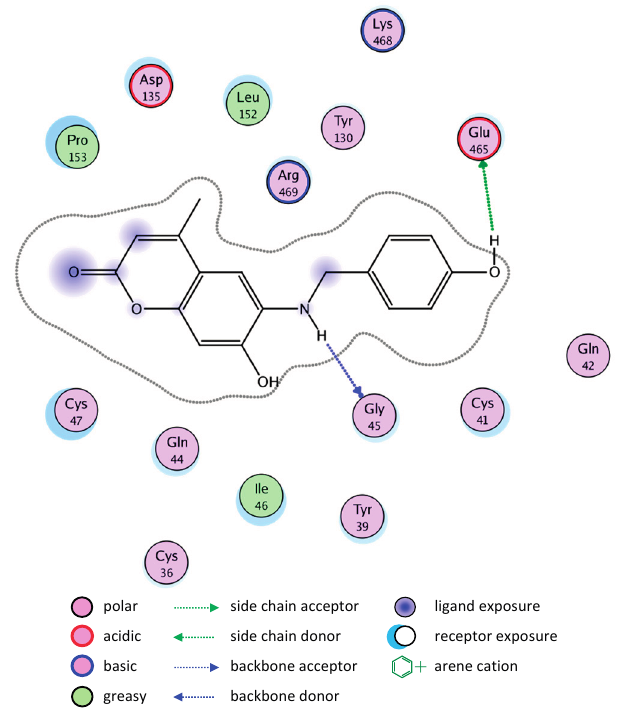
Figure 10. 2D representation of docking of compound 1 into the COX-1 active site.